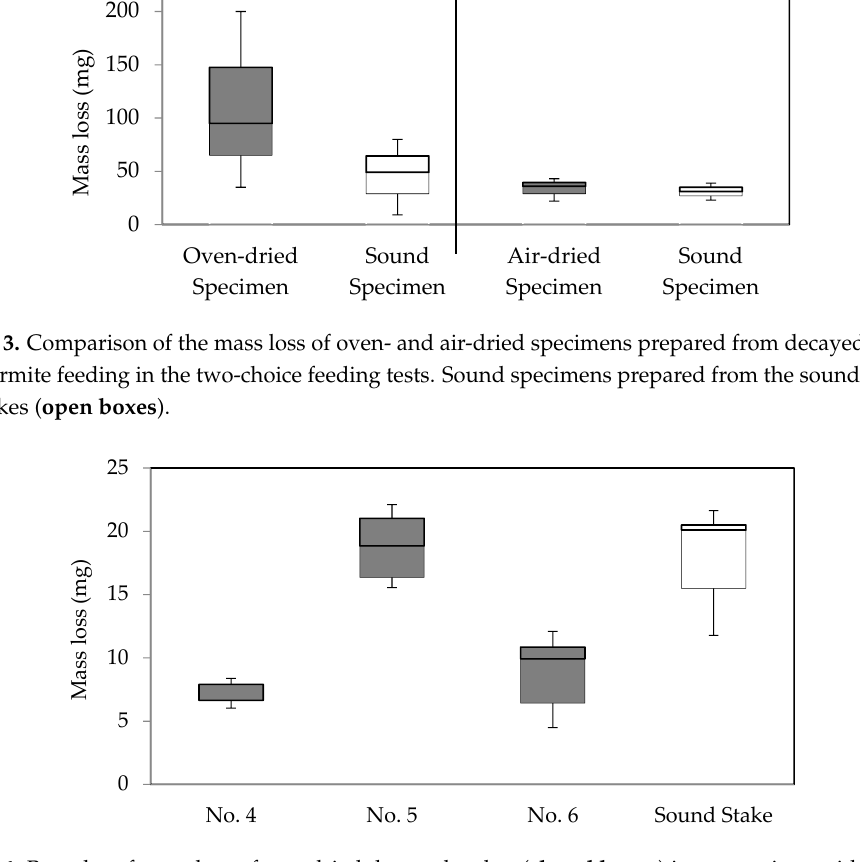
Figure 4. Box plot of mass loss of non-dried decayed stakes ( closed boxes ) in comparison with sound stakes ( open box ) after termite feeding in the no-choice feeding test. Three decayed stakes obtained from the same field (labeled as No. 4, 5, and 6) were subjected to the no-choice feeding test. Significant mass loss difference was detected at α = 0.05, X 2 (3) = 12.198, p = 0.007 (Kruskal-Wallis H test).